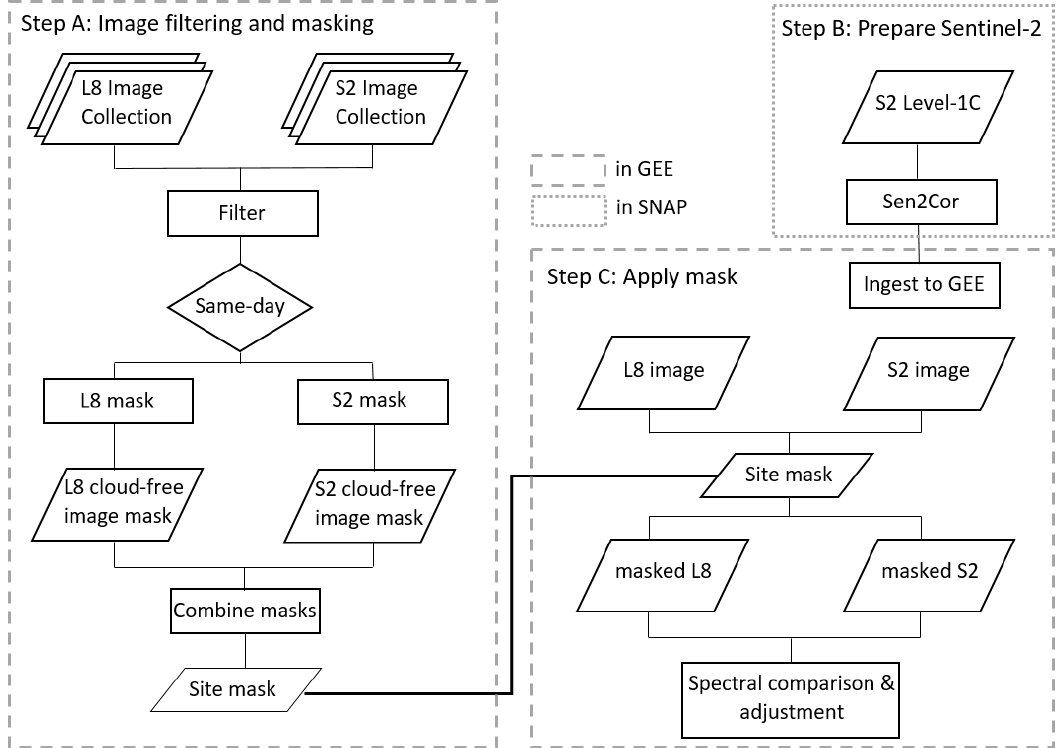
Figure 3. Data processing workflow used for the spectral band comparison and adjustment. Landsat-8 is abbreviated to L8 and Sentinel-2 to S2. Table 2. Data filtering and selection result for same-day Landsat-8 and Sentinel-2 image pairs for the three study